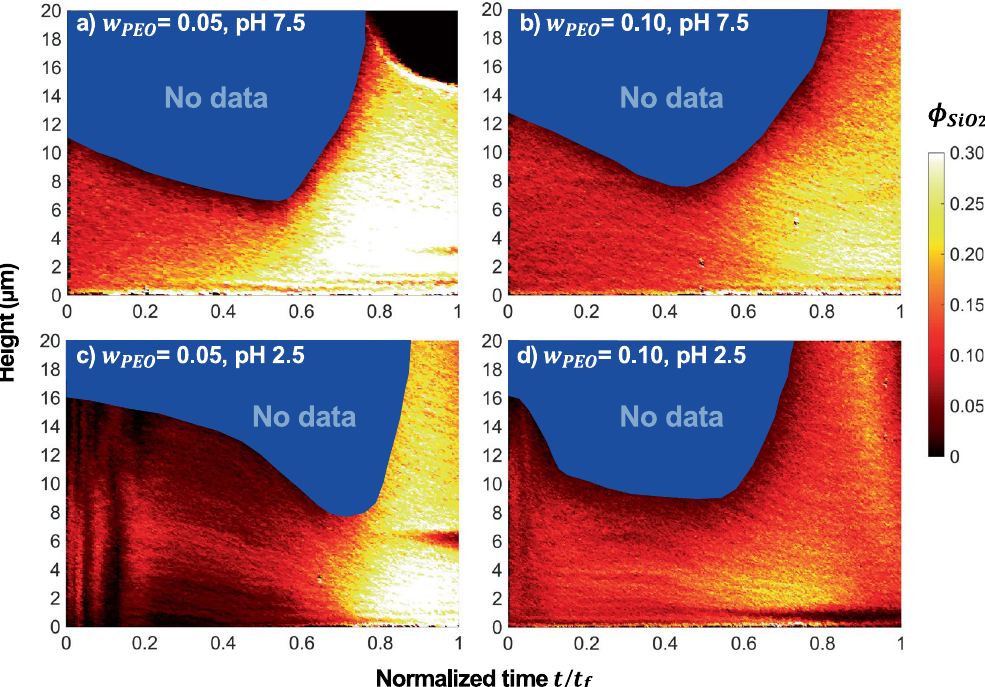
Figure 3. Concentration profile of SiO 2 microspheres in SiO 2 -PEO mixtures as a function of normalized drying time t/t f . The mixture has initial SiO 2 volume fraction φ 0 = 0.05 and PEO weight fraction ( a ) w PEO = 0.05 at pH 7.5, ( b ) w PEO = 0.10 at pH 7.5, ( c ) w PEO = 0.05 at pH 2.5, and ( d ) w PEO = 0.10 at pH 2.5. Height indicates a distance from the substrate. A change in SiO volume fraction, φ SiO , during drying is represented as a colour 2 2 scale. The depth of reduced confidence in particle location due to a mismatch of refractive index is indicated in